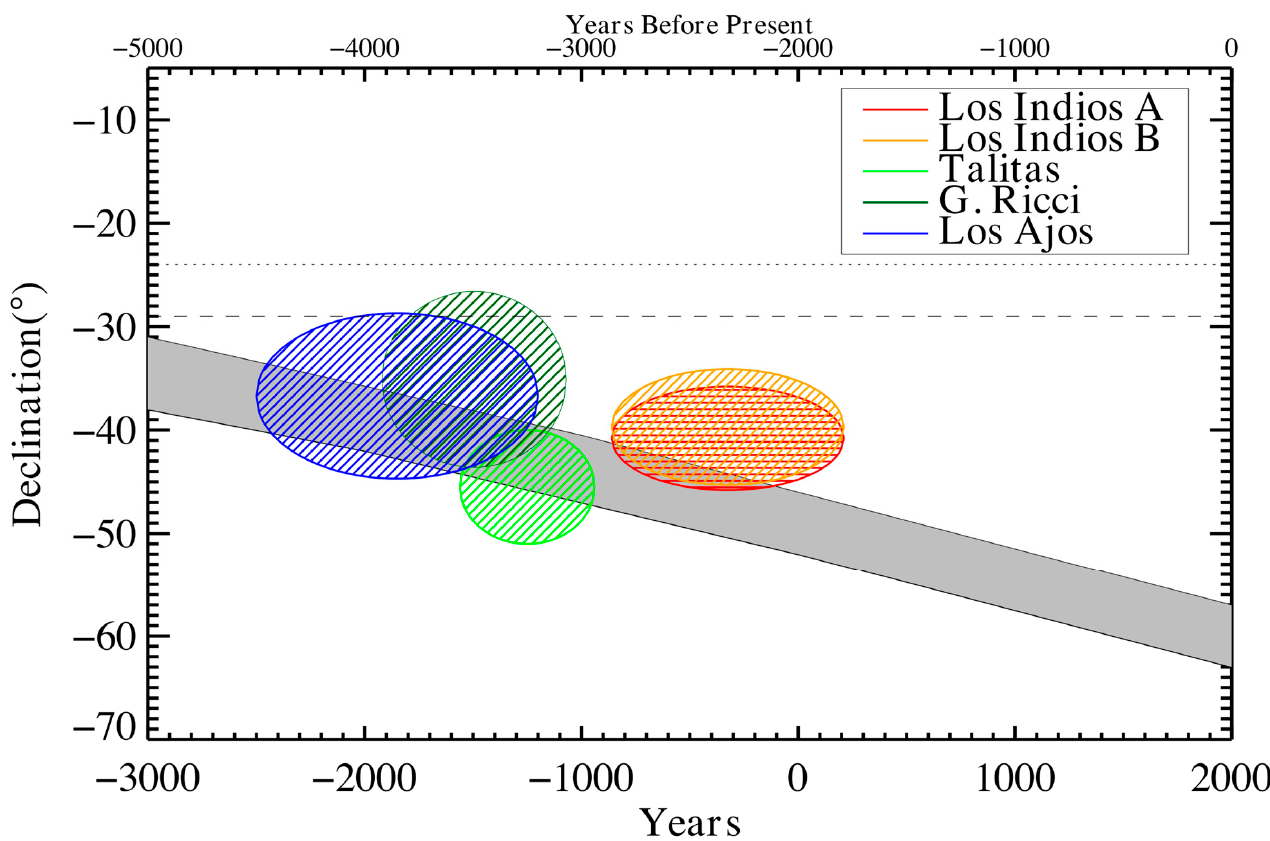
Figure 4. Dating versus declination diagram. The color ovals indicate the possible range in dates and declinations covered by the data in Table 1. The horizontal dotted line marks the location along the years of the December solstice. These changes are between nearly − 24 ◦ for 2500 BC to about − 23.5 ◦ for 2000 AD. The dashed horizontal line indicates the southernmost position of the Moon. Neither the Sun nor the Moon can be seen below this line. The light grey band indicates the area covered by the modern Southern Cross constellation.